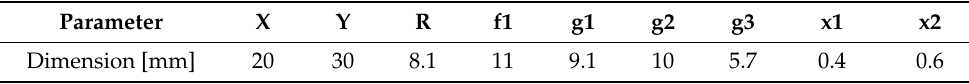
Table 1. Dimensions of the antenna